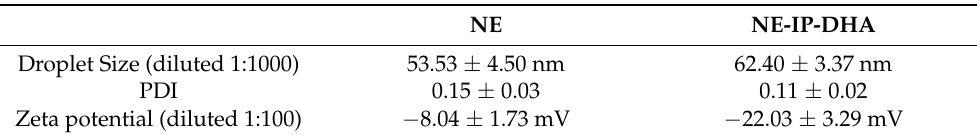
Table 4. Size, PDI, and zeta potential of NE or NE-IP-DHA in water after dilution of SNEDDS and SNEDDS-IP-DHA at 30 mg/mL ( n = 3). NE NE-IP-DHA Droplet Size (diluted